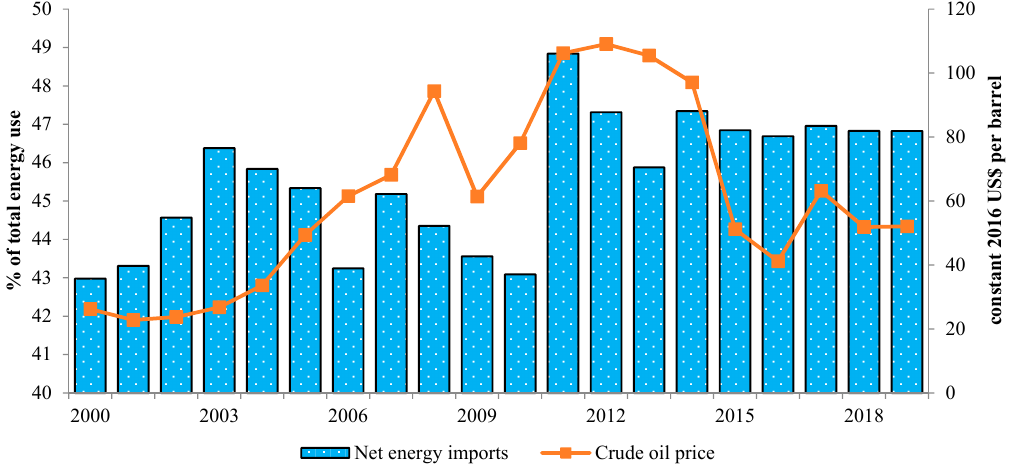
Figure 3. The trends in Sri Lanka’s energy imports and world crude oil prices. Note: Net energy imports (left axis); real crude oil price (right axis). Source: World Development Indicators [21] and British Petroleum Statistical Review of World Energy.